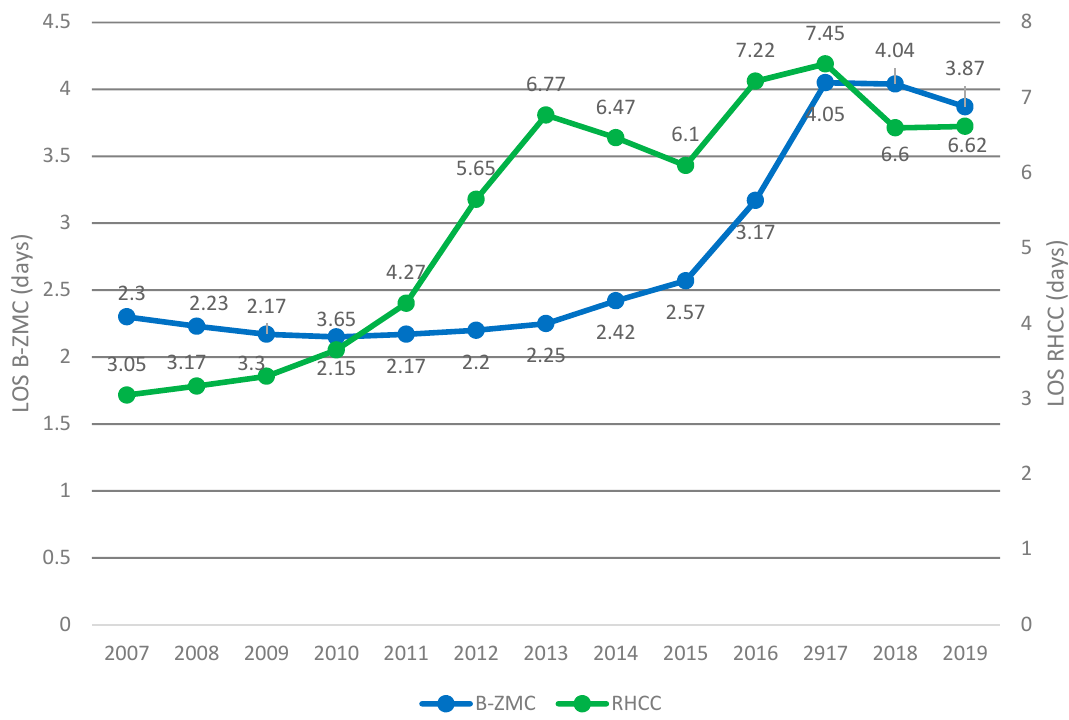
Patients’ length of stay (workup time) until decision is made (presented on a double vertical axis: left = B-ZMC, right = RHCC).